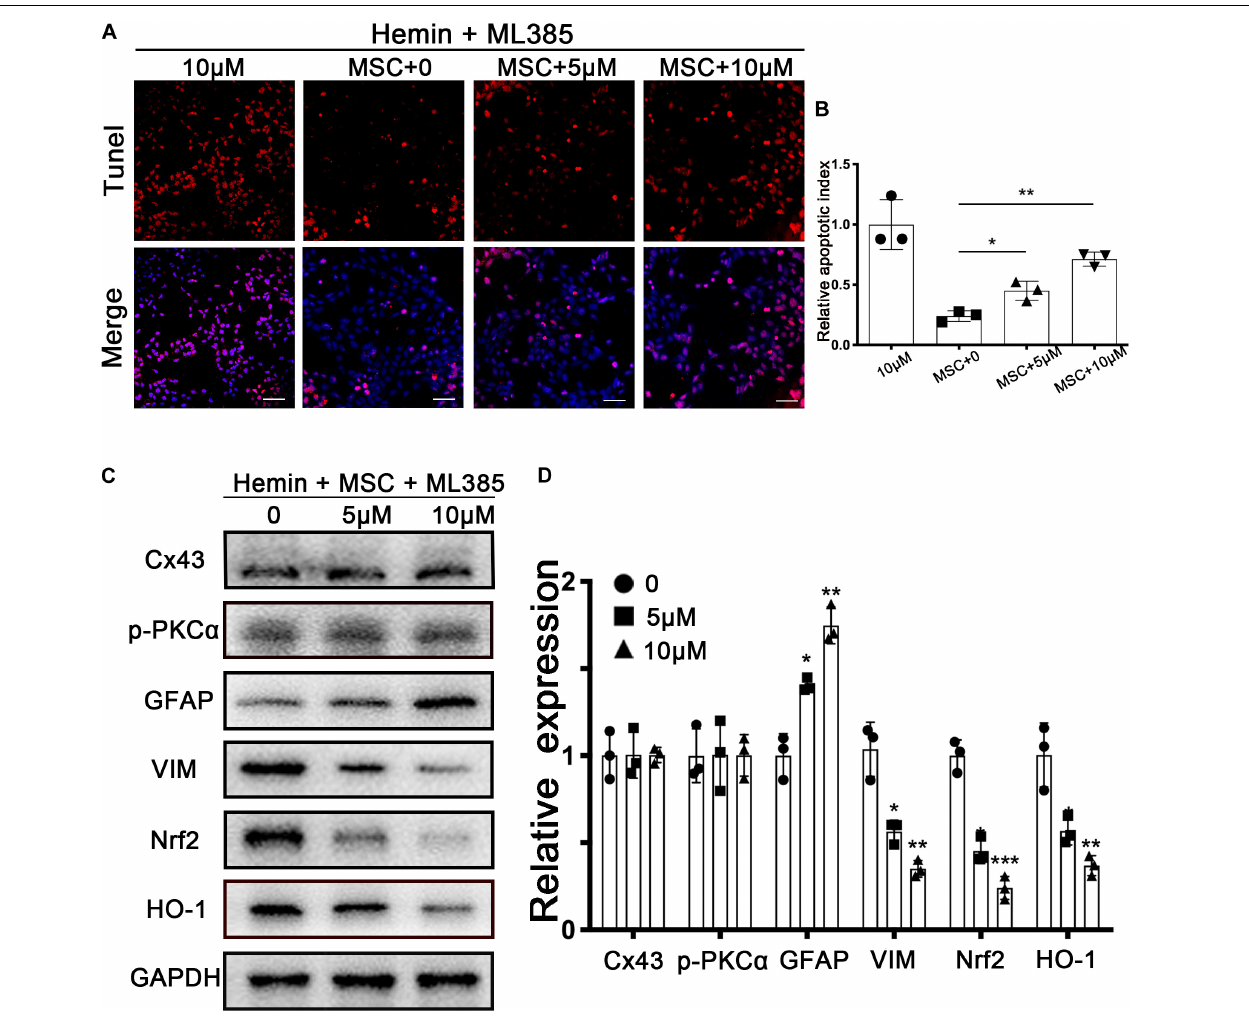
FIGURE 6 | Nrf2 inhibitor ML385 counteracted BM-MSCs coculture induced antioxidation and GFAP/VIM switch. Astrocytes were administrated with or without ML385 for 6 h, then followed by 30 µ M hemin incubation, with or without BM-MSCs coculture treatment. (A) TUNEL staining (red) was used to mark apoptotic cells. Bar = 50 µ m. (B) The results of the apoptosis rate and densitometric analysis of the bands were plotted into a histogram of five randomly fields. (C,D) Western blotting analysis of Cx43, GFAP, VIM, Nrf2, HO-1 protein expression was examined. The relative expression was normalized to control. All data are displayed as means ± SD ( n = 3). The difference between groups was analyzed using One-way ANOVA test. * p < 0.05, ** p < 0.01, *** p < 0.001, compared with control (ML385 0 µ